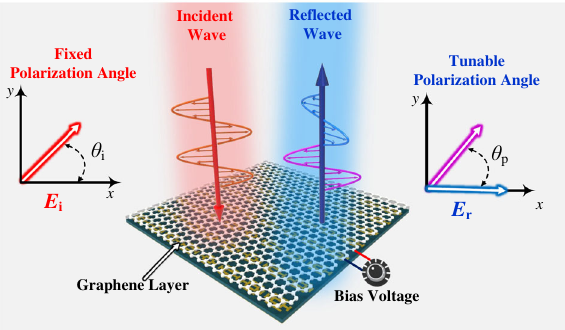
Fig. 2 Schematic diagram of the proposed graphene-based meta- device. a Schematic view of the proposed meta-device. b Side view of GSL and c top view of metallic periodic cross-shaped resonator. Geometric parameters are p = 6 mm, w = 0.4 mm, a = 3.6